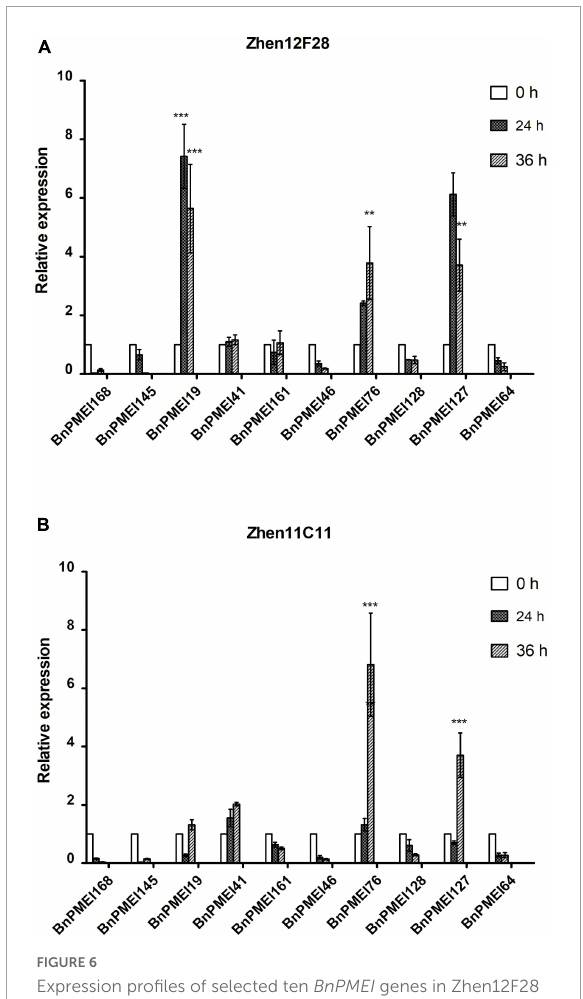
FIGURE6 Expression profiles of selected ten BnPMEI genes in Zhen12F28 (R-line) (A) and Zhen11C11 (S-line) (B) after S. sclerotiorum infection. The relative expression levels were analyzed by qRT-PCR. Error bars are mean ± SEM, n = 3. Significant differences between infected lines and the control (WT) line (0 h) at each time point are denoted as follows: *** P < 0.001; ** P <